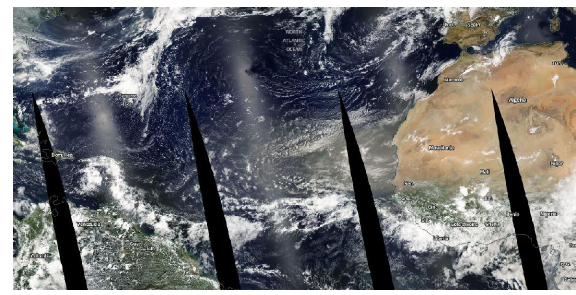
Figure A4. Dust storm on 8 August